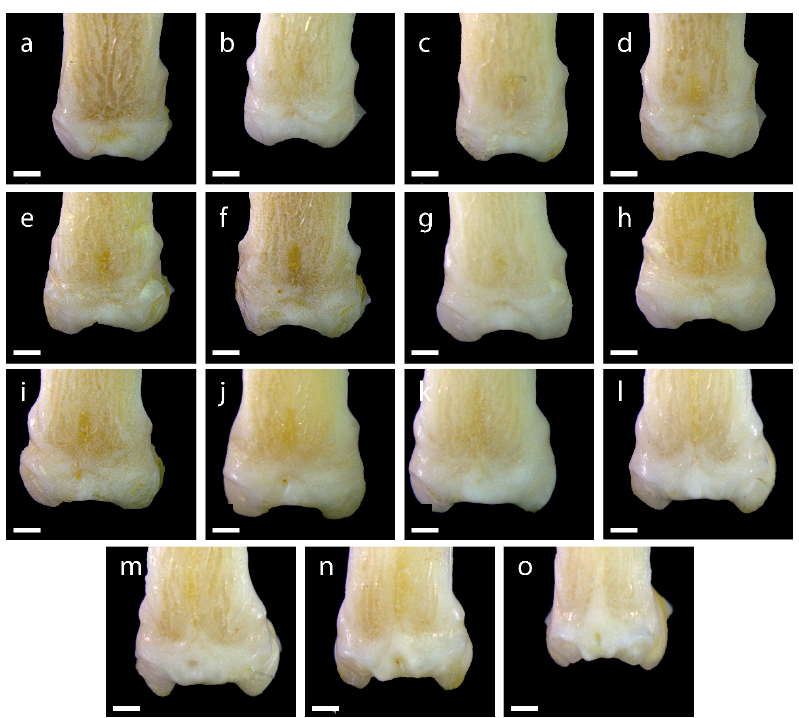
Figure A9. Microscopic images of the anterior view of the pinnules of P. bichir PO5. The images ( a – o ) correspond to the 1st, 2nd, 3rd, 4th, 5th, 6th, 7th, 8th, 9th, 10th, 11th, 12th, 13th, 14th, and 15th pinnules, respectively. Scale bars = 1 mm.